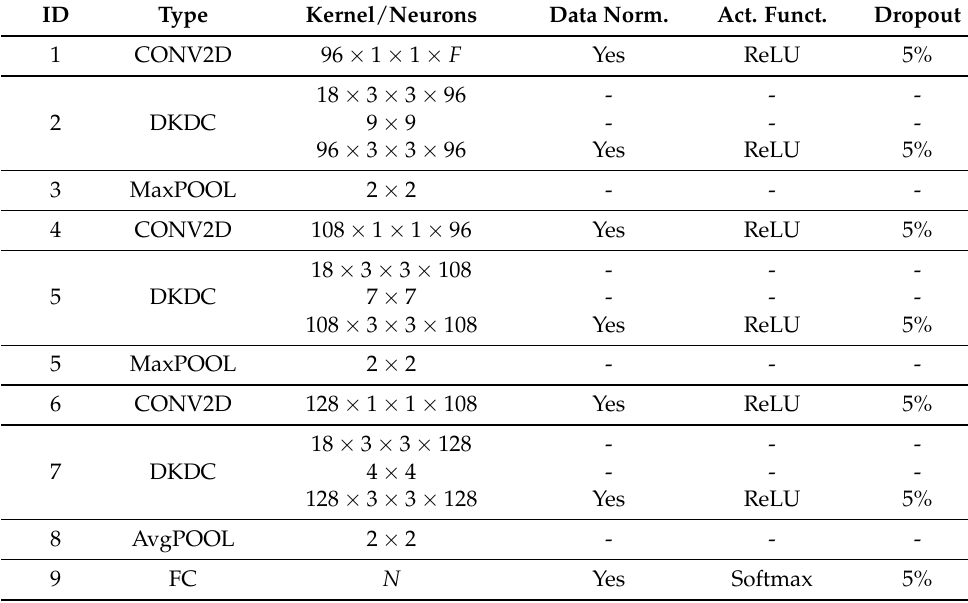
Table 1. DKDCNet